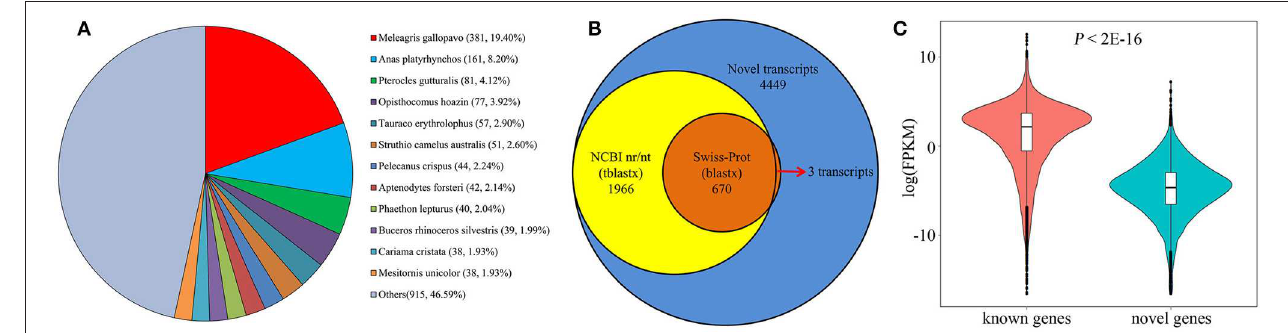
FIGURE 7 | Identification of novel protein coding genes from chicken embryos. (A) Species distribution shows the highest match for each novel transcript in the tblastx search against NR database. (B) The number of identified novel transcripts (blue), and transcripts with significant sequence similarity in a tblastx search against NCBI nr/nt database (yellow) or a significant match in a blastx search against Swiss-Prot database (orange). (C) Comparison of mRNA expression level between known and novel protein coding